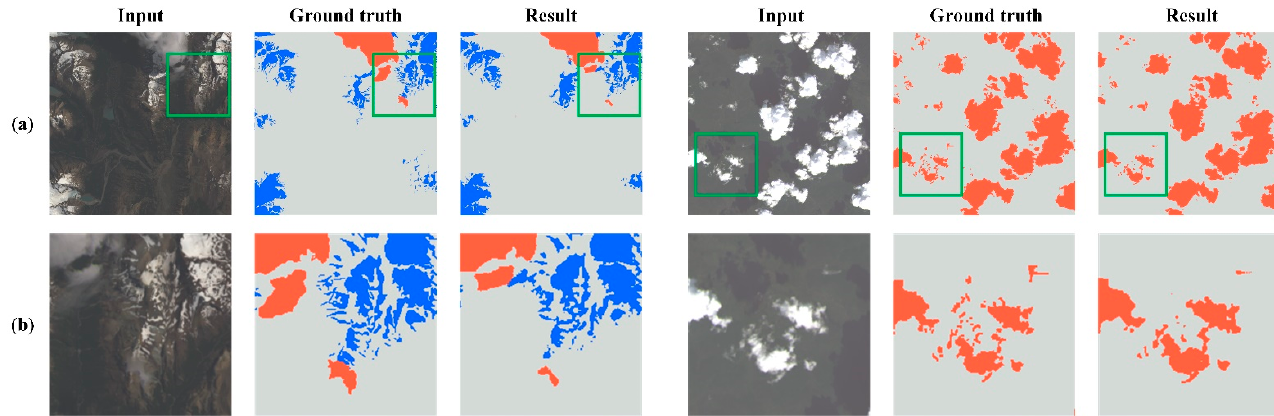
Figure 23. Error cases in challenging cloud and snow detection scenes. ( a ) The remote sensing images with detection errors. ( b ) The delineated areas in ( a ) with the green boxes were magnified to provide a more detailed visual comparison.